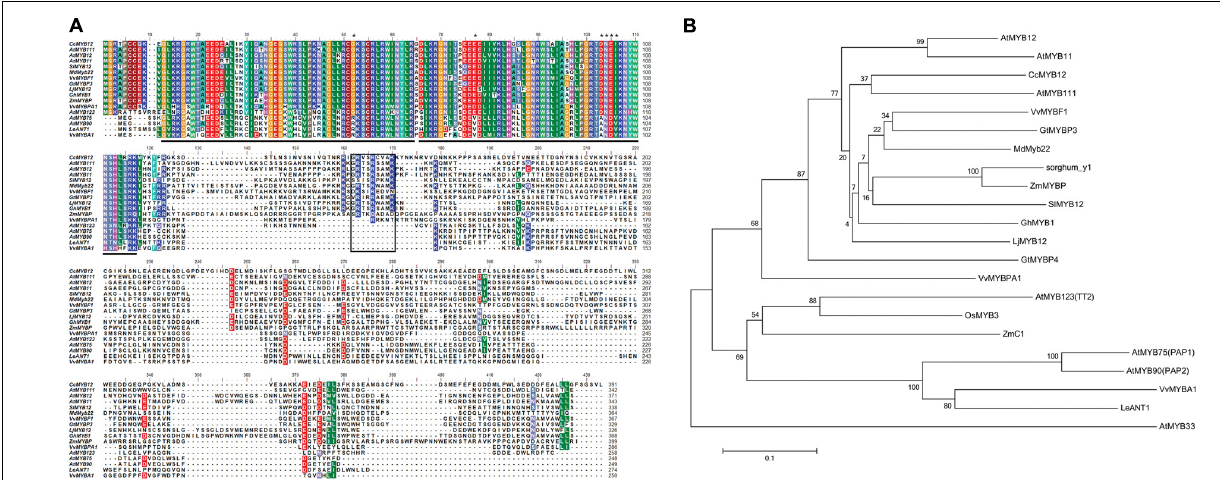
FIGURE 1 | Protein sequence alignment of CcMYB12 deduced amino acid sequence with plant R2R3-MYB transcription factors and phylogenetic analysis. (A) Protein sequence alignment of CcMYB12 with representative members of R2R3-MYB-type transcriptional regulators of flavonols, proanthocyanidins and anthocyanins from other plant species. The position of the R2 and R3-type MYB domains is indicated below the alignment by gray bars, the SG7 domain is highlighted by a black box. Key amino acid residues are indicated by asterisks. (B) Phylogenetic analysis of deduced amino acid sequences of R2R3-MYB transcription factors present in higher plants. The Neighbor-Joining phylogenetic tree was generated using MEGA software (Tamura et al., 2013). Numerals next to branch nodes indicate bootstrap values from 10000 replications. The bar indicates an evolutionary distance of 0.1%. Protein accession numbers are as